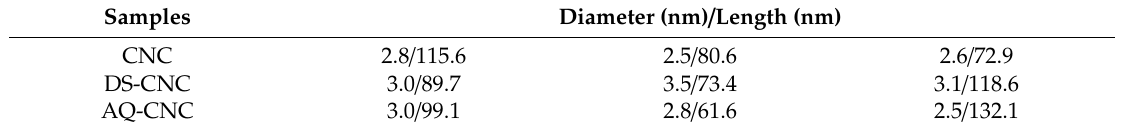
Figure 2. AFM topographic images (1.2 µ m × 1.2 µ m) of ( a ) CNCs, ( b ) DS-CNCs, and ( c ) AQ-CNCs. All images were acquired using tapping mode in ambient conditions. Scale bars: 0.2 µ m. AFM amplitude images of aggregates are shown for ( d ) CNC, ( e ) DS-CNC, and ( f ) AQ-CNC samples. Scale bars: 0.5 µ m. Table 1. Dimensions of individual CNCs measured from Figure